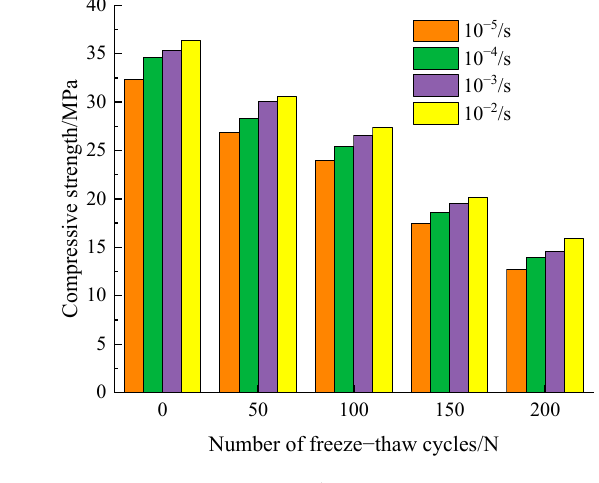
Figure 10. Variation of RDME with different freeze–thaw cycles.